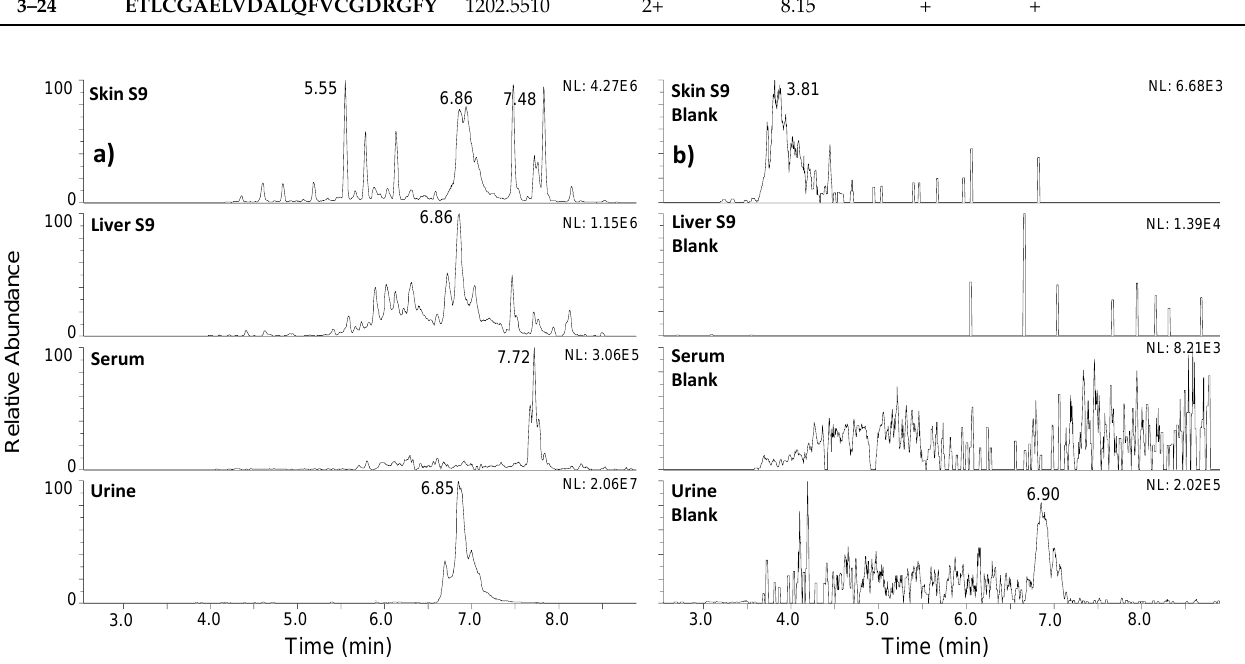
Figure 5. AIF chromatogram extracted at m / z 137.073 corresponding to the 15 N-Tyr immonium ion obtained after incubation of 15 N-IGF-I in different biological fluids ( a )) compared to the respective substrate blanks ( b )).